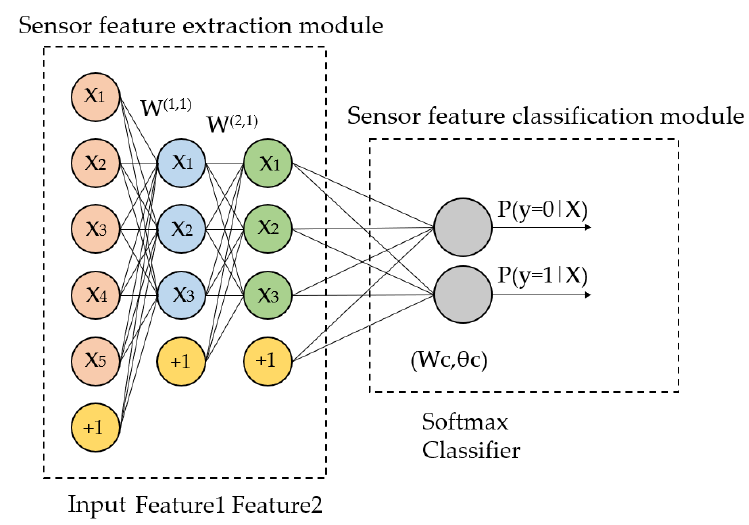
Figure 4. The feature extraction sensor classification model, SAEM,